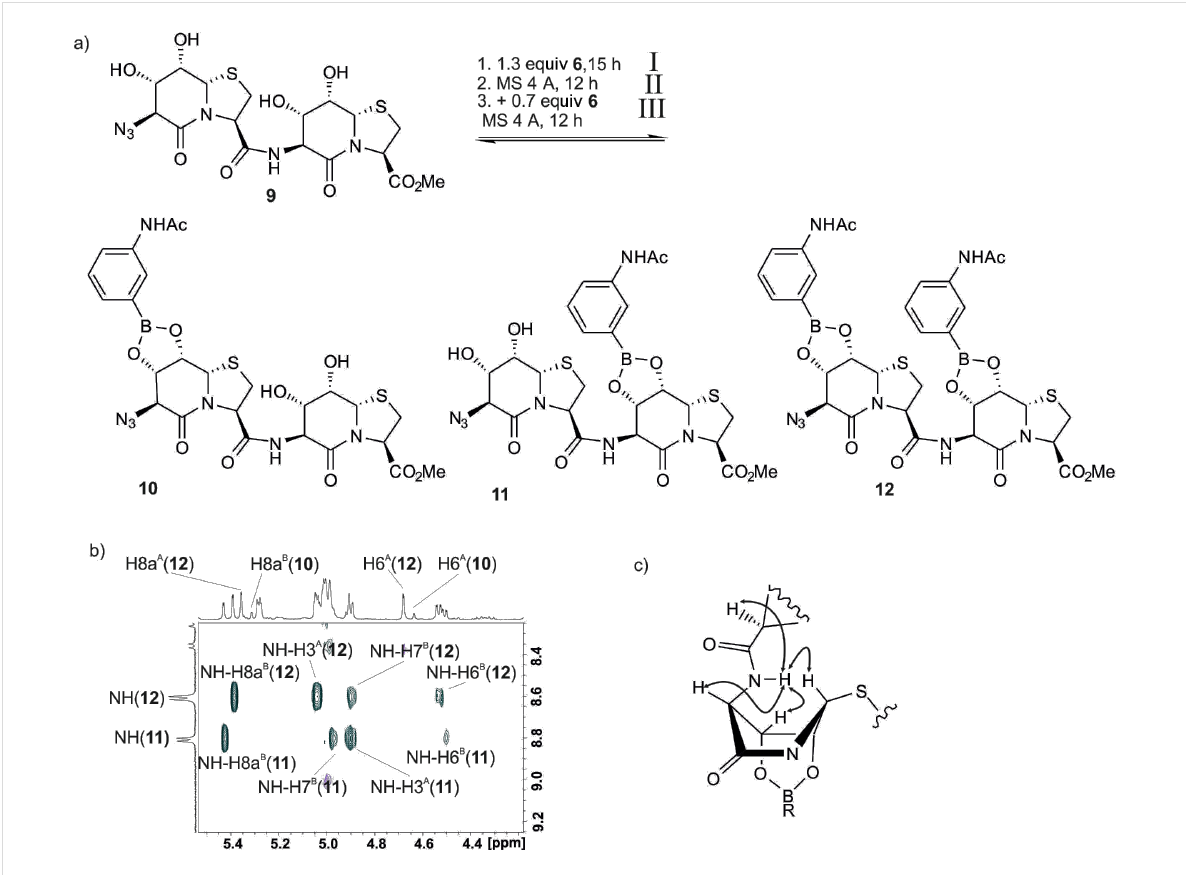
Figure 6: Template 9 and boronic acid 6 can form the monoesters 10 and 11 , or the diester 12 . The signal assignments were performed by homo- (DQF-COSY, TOCSY) and heteronuclear (HSQC, HMBC) 2D NMR methods. The NOESY spectrum identifies the position and the relative orientation of the aryl group of the boronic ester to the valerolactam ring of Hot.